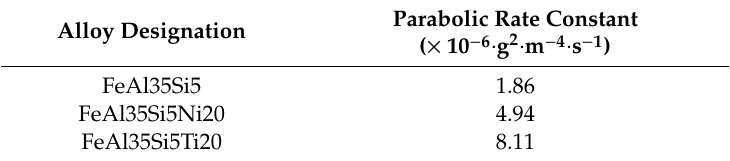
Table 4. Calculated parabolic rate constants of the cyclic oxidation of the tested